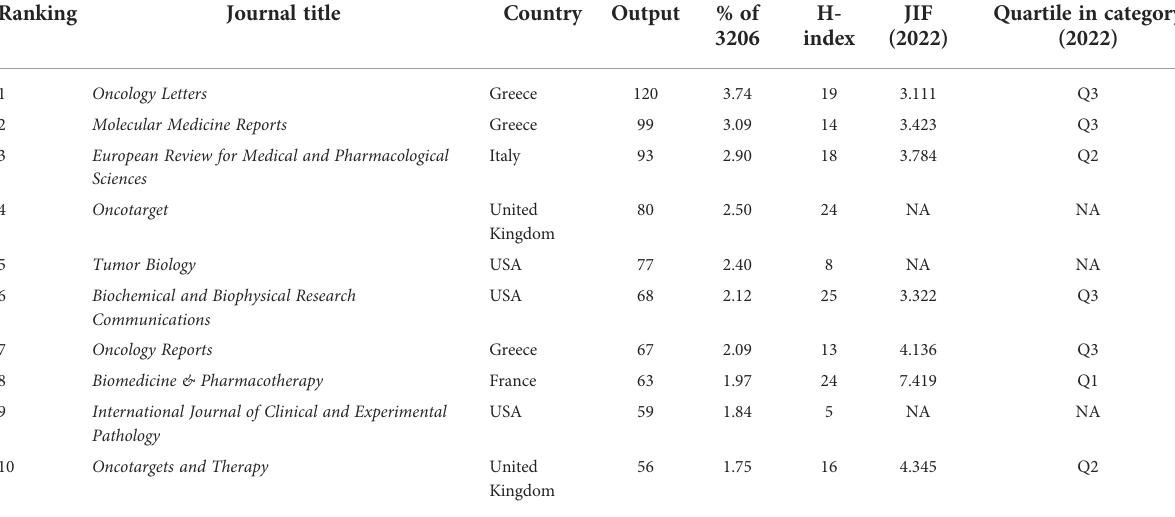
TABLE 1 Top 10 journals with most publications about ncRNAs of osteosarcoma.